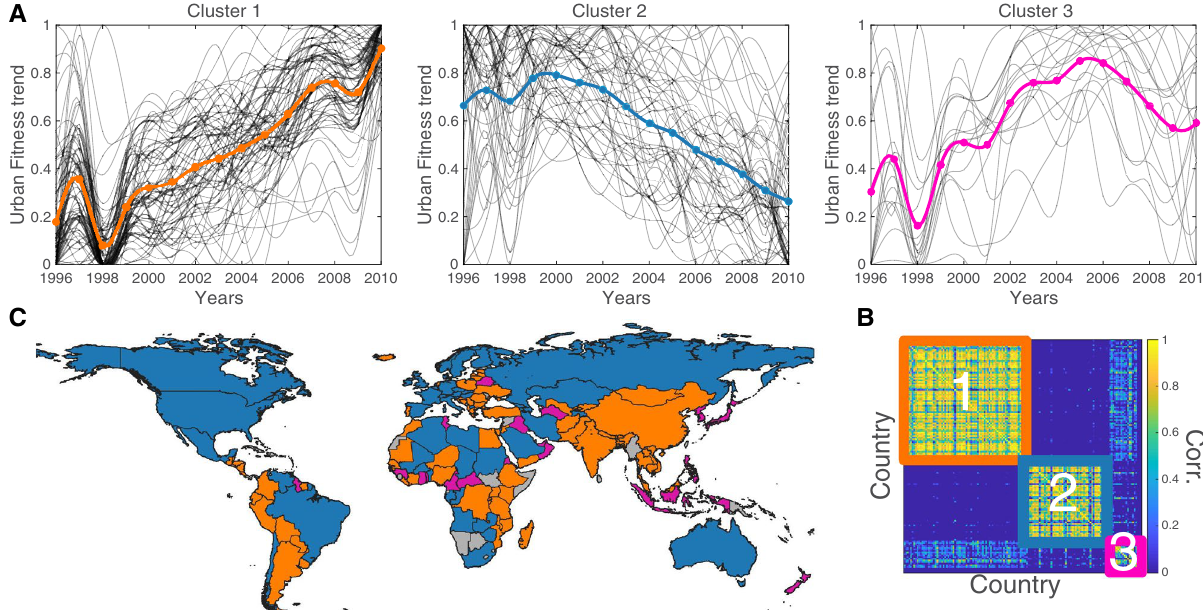
Figure 4. ( A ) Clusters of normalized Urban Fitness Trends. ( B ) Correlation Matrix of the countries urban fitness trends clustered with the Louvain algorithm. ( C ) Geographical cluster distribution. The map in this figure was created using the software